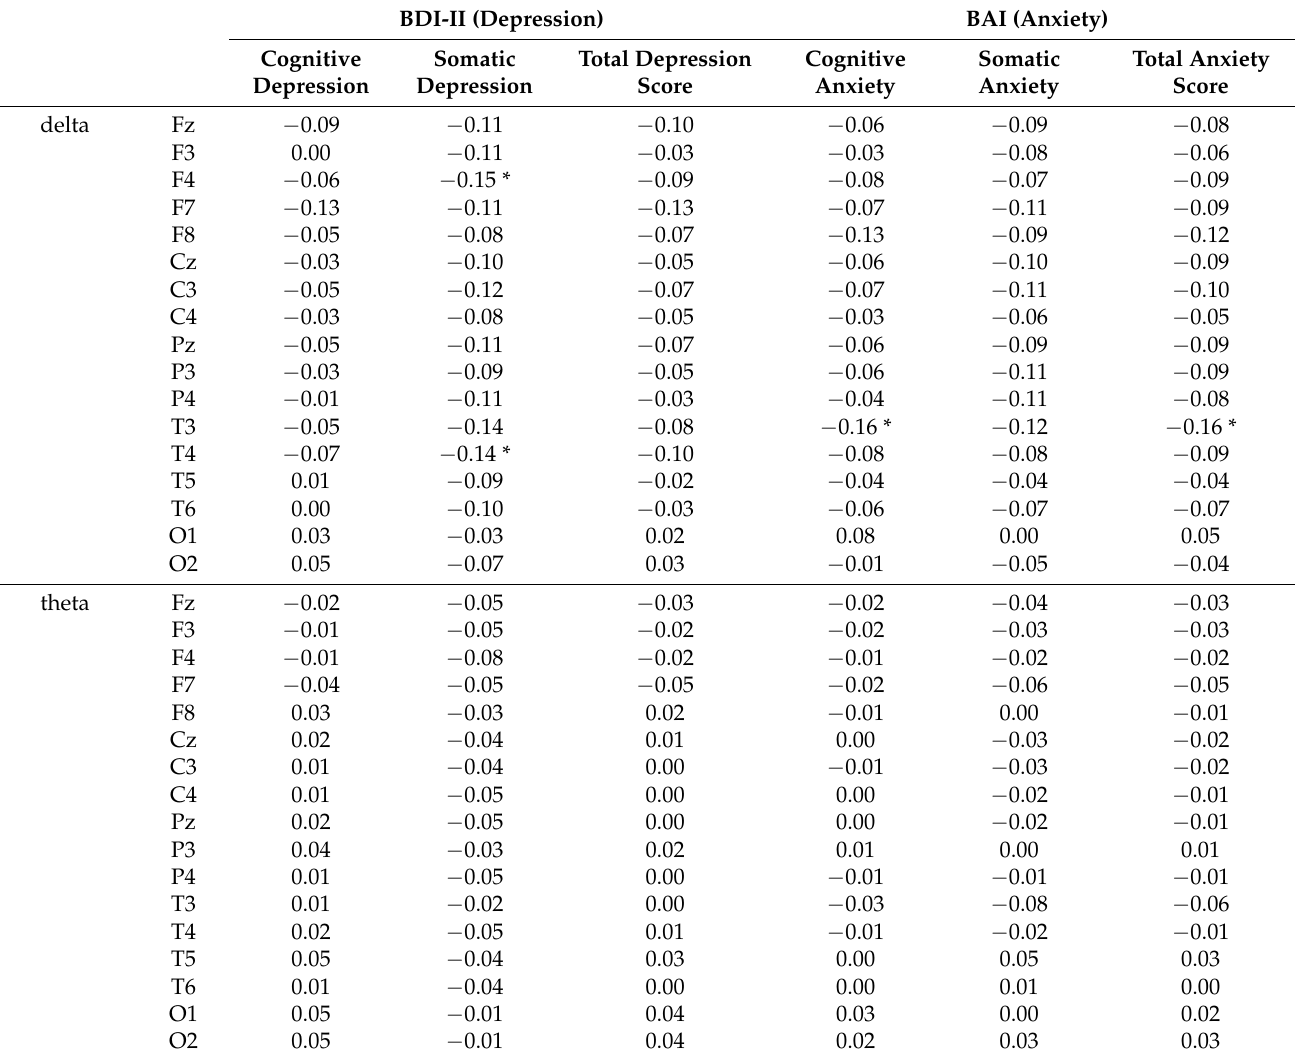
Table A1. The correlations between BDI-II, BAI, and z-scores in the MDD